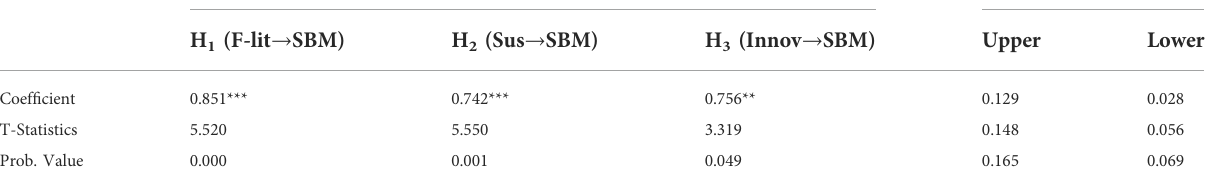
TABLE 6 hypothesis testing and their outcomes.